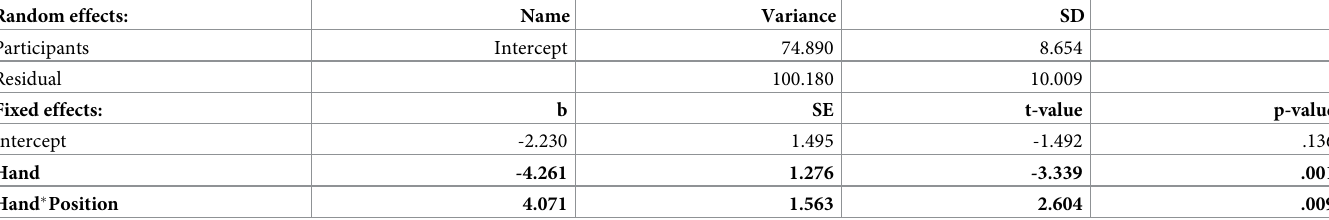
Table 1. Model 1.1. Main effect of hand on grip force in the time window 820–1000 ms (Experiment 1). Random